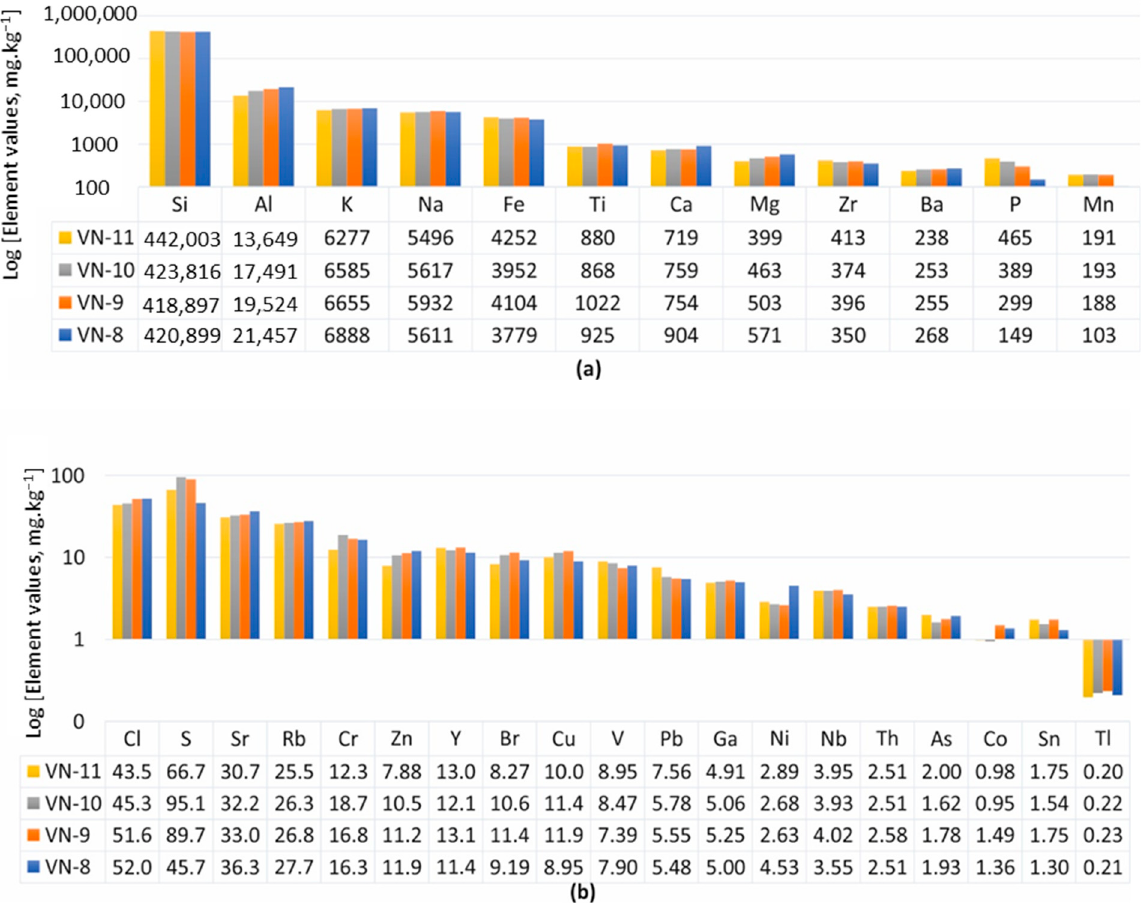
Figure 2. Comparison of element values (mg kg − 1 ) in the soils samples (VN-8–VN-11) of the Voorthuizen archaeological site: ( a ) Macro-elements (Si, Al, K, Na, Fe, Ti, Ca, Mg, Zr, Ba, P, and Mn) values; ( b ) Micro-elements (Cl, S, Sr, Rb, Cr, Zn, Y, Br, Cu, V, Pb, Ga, Ni, Nb, Th, As, Co, Sn, and Tl). Values are expressed in logarithmic scales, for visual